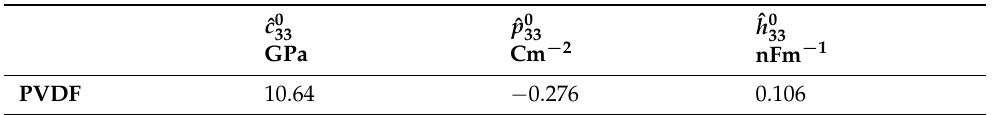
Table 2. Constitutive coefficients of the thin adhesive [55]. The values in the table refer to the material in undamaged